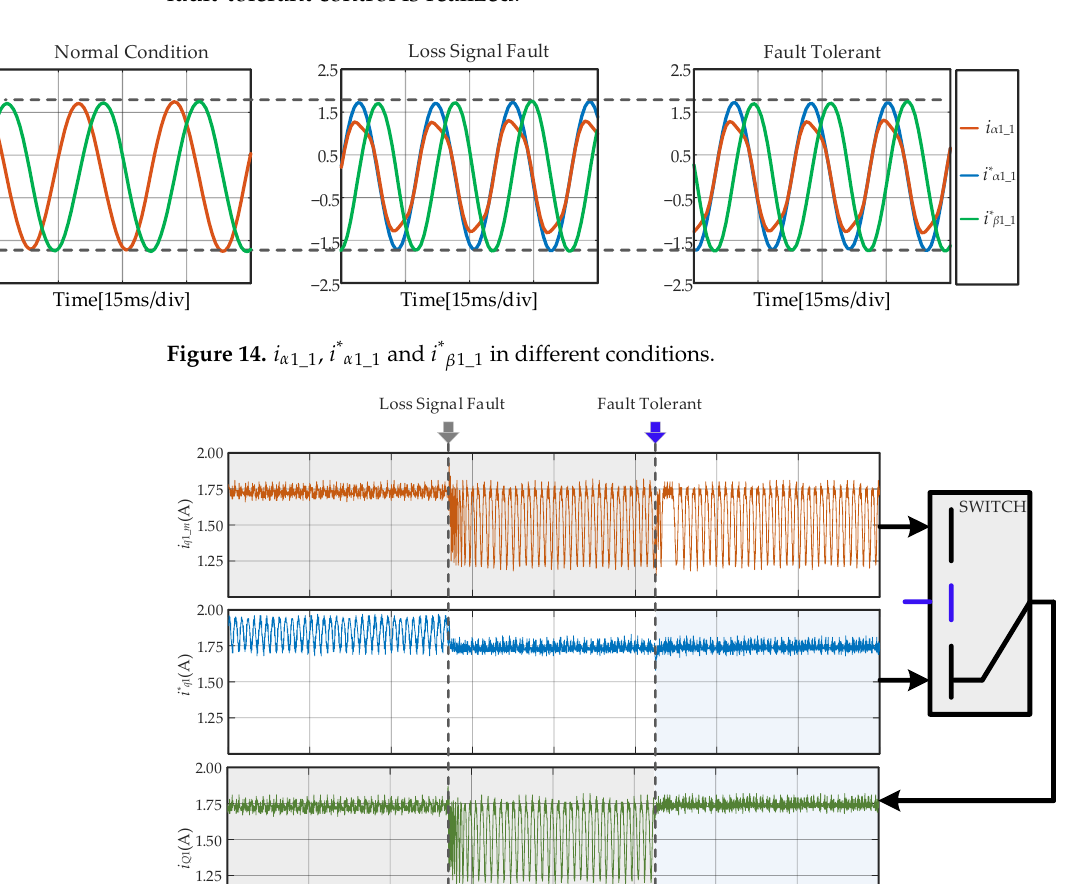
Figure 15. i q 1_m , i *q 1 and i Q 1 in different conditions.